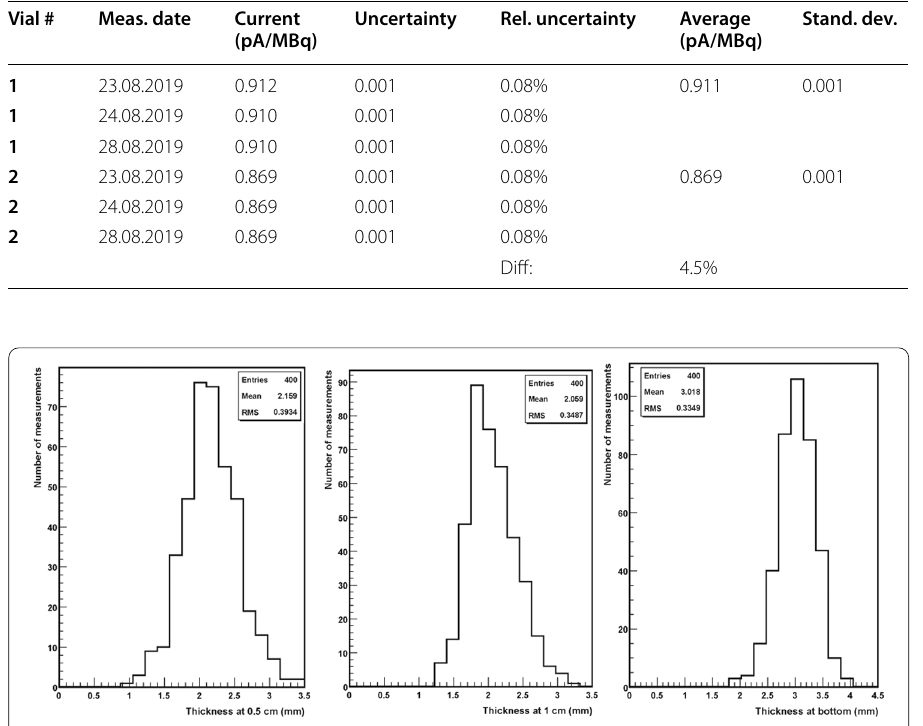
Fig. 6 Distributions of the thicknesses measured for the three positions of the probes for 40